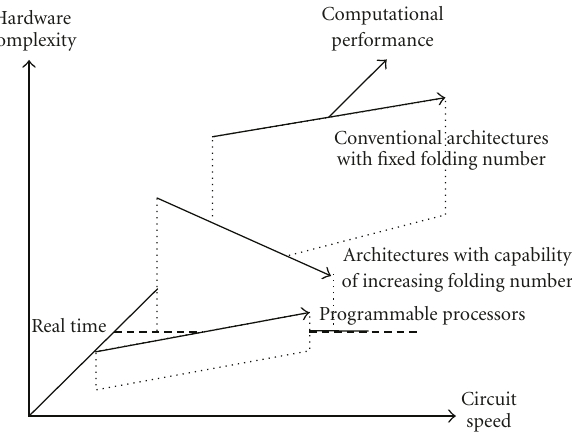
Figure 1: The relationship between computational performance, hardware complexity, and circuit speed on di ff erent hardware plat- forms to realize a high-tap-number FIR